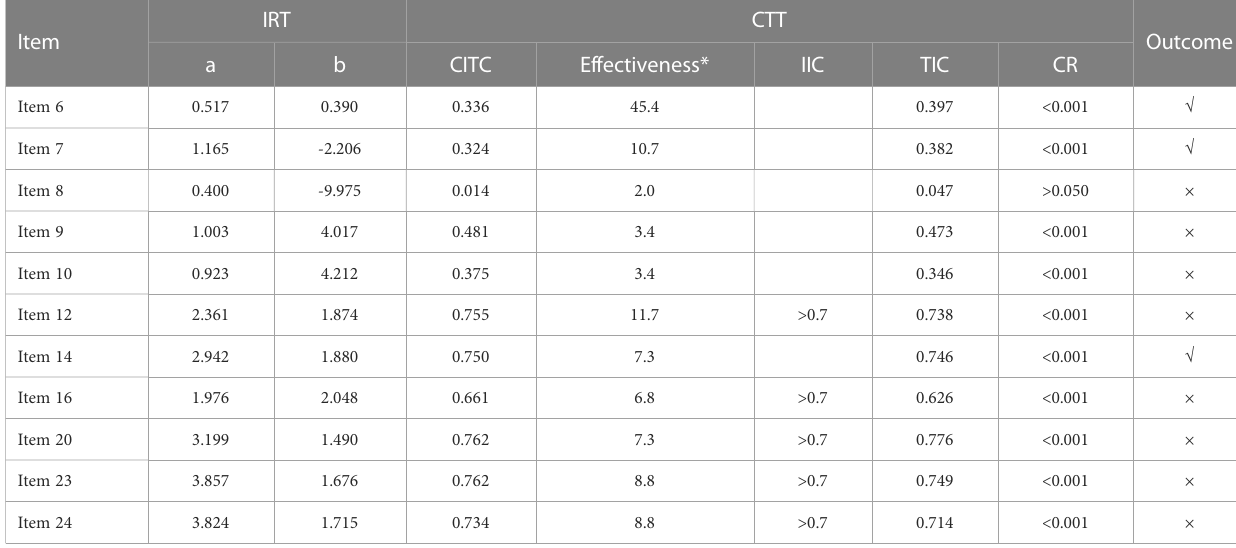
TABLE 1 Item reduction results using the IRT and